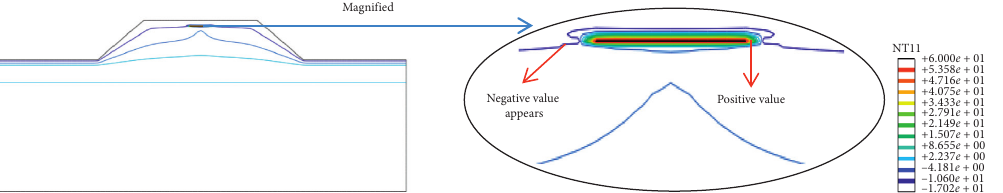
Figure 13: Temperature distribution characteristics of the polymer grouting material when the central temperature decreased to 60 °